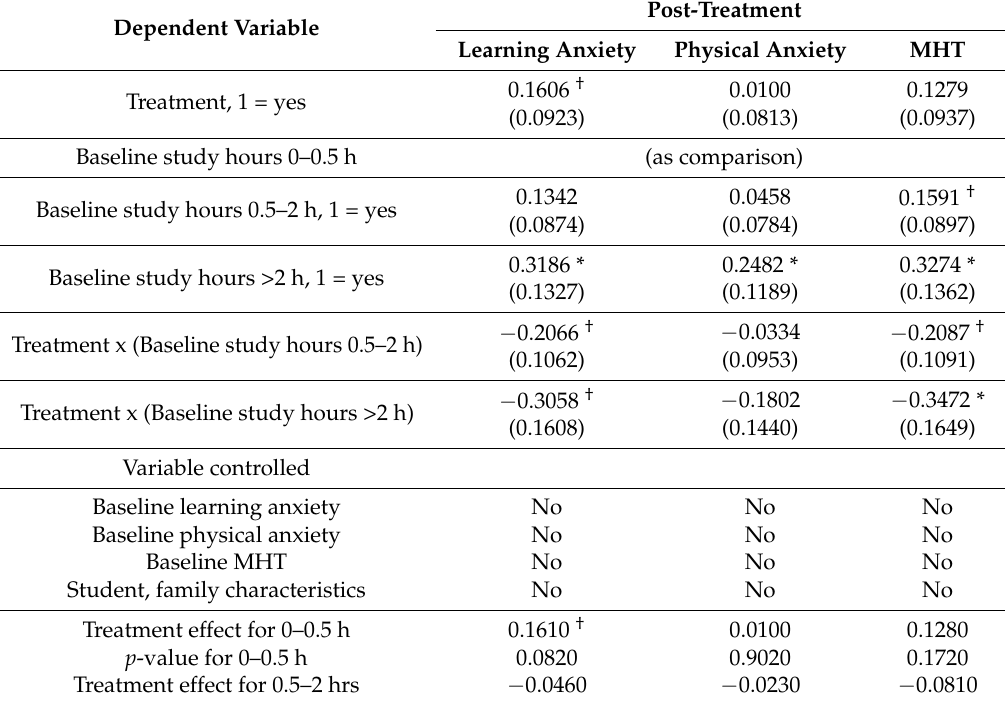
Table A4. Impact of Providing Fully Subsidized Eyeglasses on Mental Health by Daily After-class Study Time (without